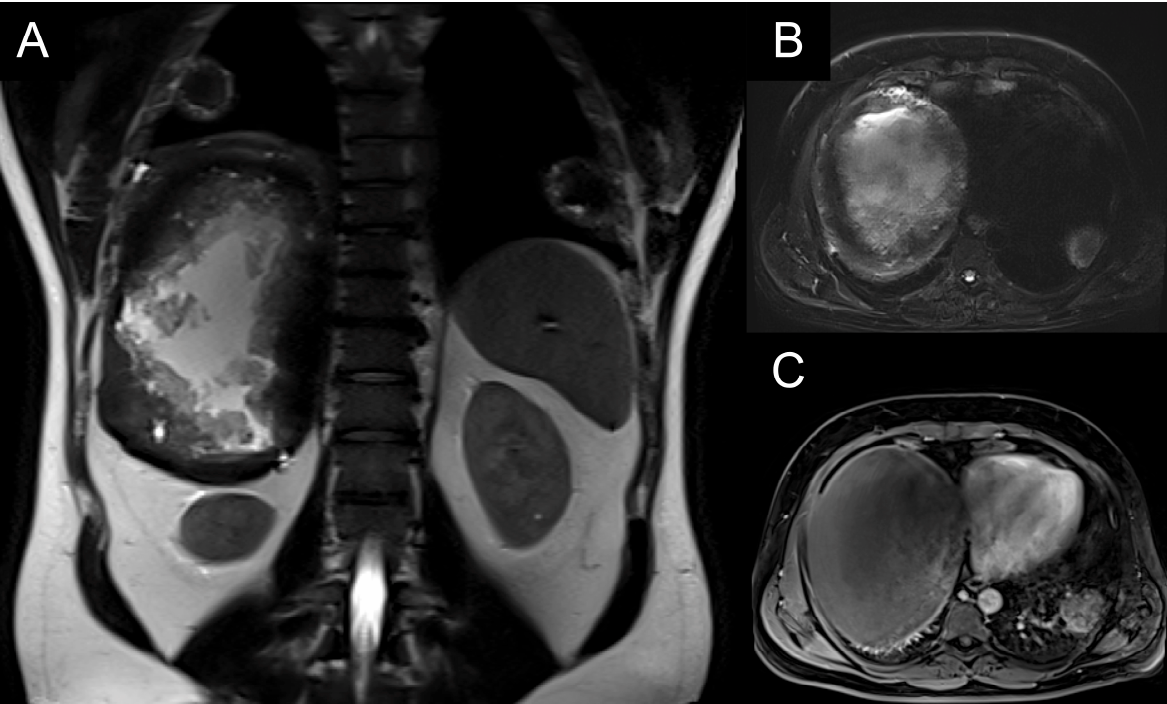
Figure 1. ( A , B ): T2-weighted hyperintense liver lesion; ( C ): T1-weighted hypointense liver lesion with abnormal pulmonary lesions.